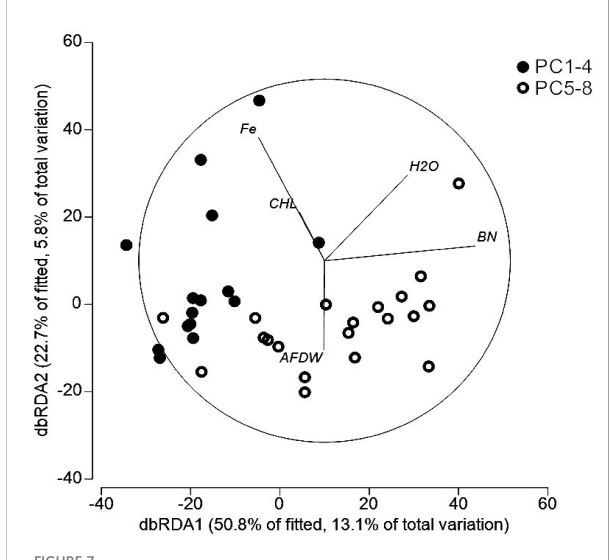
FIGURE 7 Distance-based redundancy analysis ordination to investigate relationship between the environmental variables and nematode communities in ferrous and non-ferrous sediments. CHL: chlorophyll a ; BN: bacterial numbers; AFDW: total organic matter measured as ash-free dry-weight of the sediments; H2O: sediment porosity indicated by the water content of the